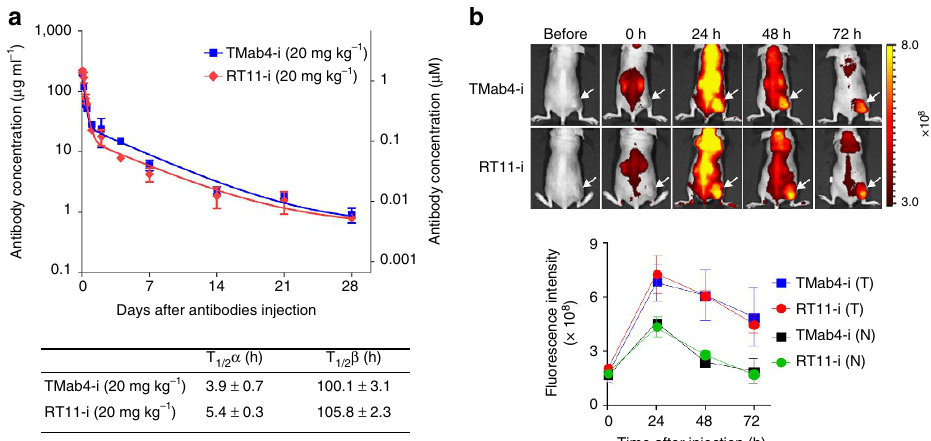
Figure 5 | Pharmacokinetics and biodistribution of RT11-i and TMab4-i antibodies. ( a ) Pharmacokinetic profiles of RT11-i and TMab4-i in non-tumour bearing mice. Serum concentrations of TMab-i and RT11-i were determined by ELISA in female BALB/c nude mice following a single intravenous injection of 20mgkg (cid:3) 1 in a total volume of 200 m l. Error bars represent the mean ± s.d. ( n ¼ 3 per time point). The solid lines represent the fit of a two-compartment pharmacokinetic model to the data to estimate the initial rapid clearance phase (T 1/2 a ) and later terminal serum clearance phase (T 1/2 b ). The inset table shows the pharmacokinetic parameters. ( b ) Tumour-targeting ability of RT11-i and TMab4-i, evaluated by intravenously injecting Dylight755-labelled antibodies (20 m g per mouse) into SW480 xenograft tumour-bearing mice, followed by in vivo fluorescence imaging. Representative images are shown, which were acquired at the indicated times post-injection. Fluorescence intensities in the tumour tissue (T), as indicated by arrows, and normal tissues (N) were quantified by radiant efficiency (photons s (cid:3) 1 cm (cid:3) 2 steradian (cid:3) 1 m W (cid:3) 1 cm (cid:3) 2 ) using Living Image software. Error bars, ± s.d. ( n ¼ 5 per group).